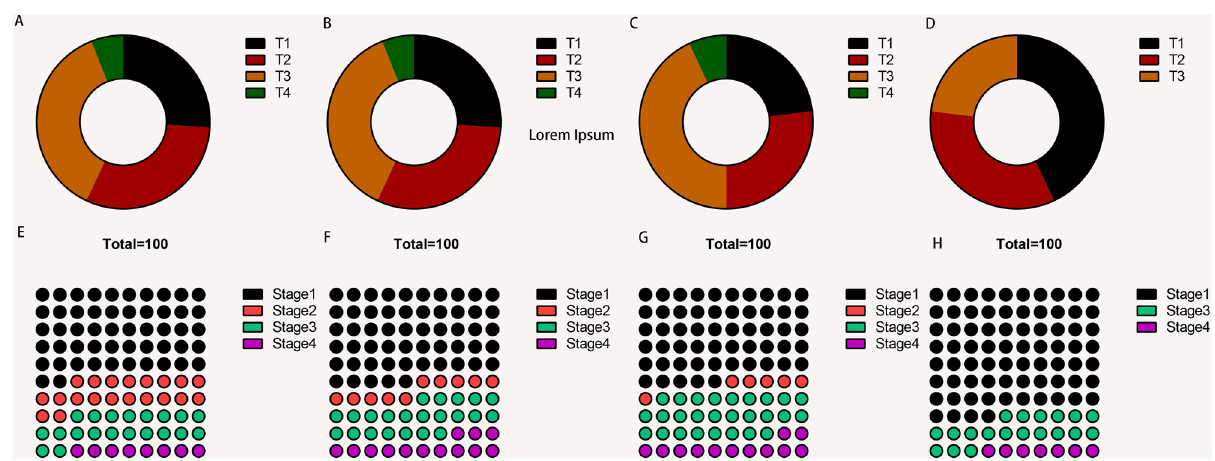
Figure 5. Tumor size distribution and grading in different subtypes. ( A – H ) The distribution ratio and grading of thyroid tumor sizes in different clusters. The ratio of Cluster 4 in T1 and Stage 1 was significantly higher than that of the other